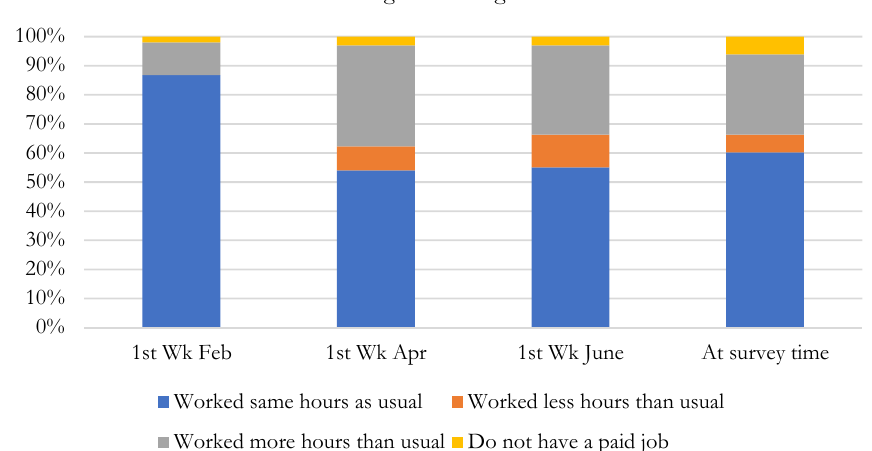
The respondents’ employment status, work location and working hour pre- and during the COVID-19